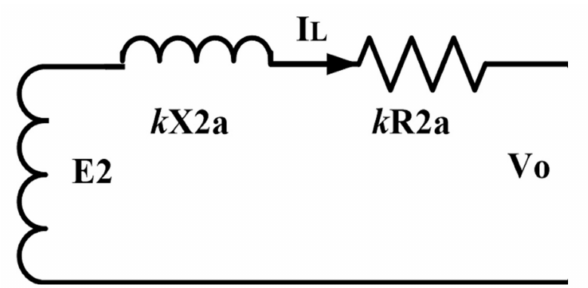
Figure 15. Per-phase equivalent circuit of the secondary